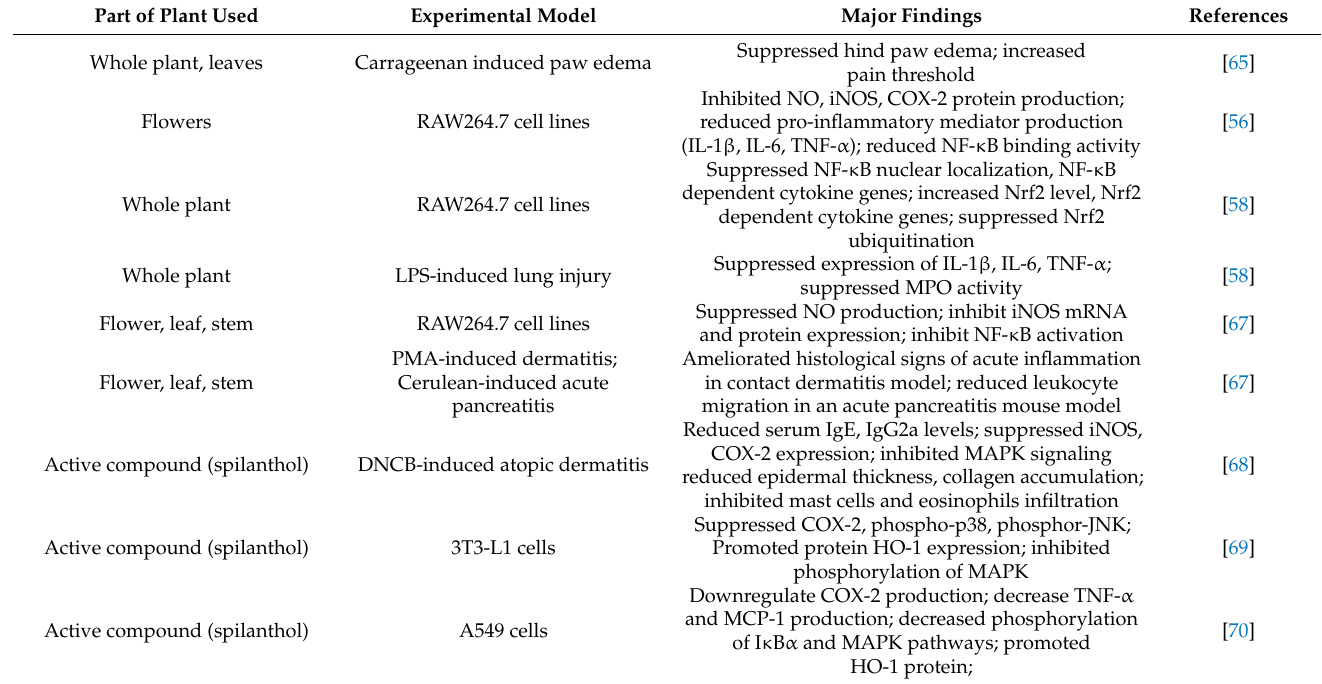
Table 3. Summary of anti-inflammatory actions of S.